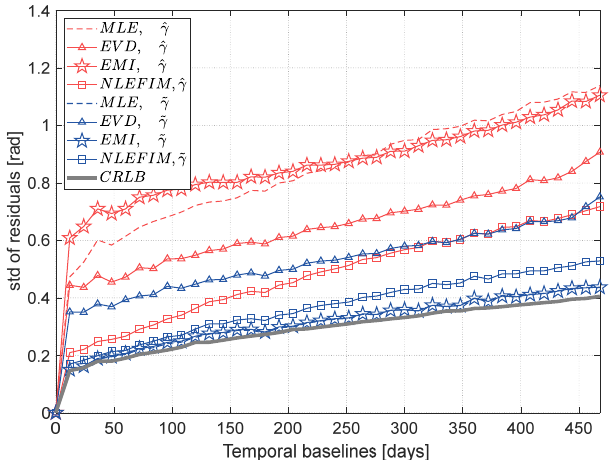
Figure 14. Standard deviation of the residuals for reconstructed phase series using different phase estimators. The colors indicate the coherence matrix estimator used.